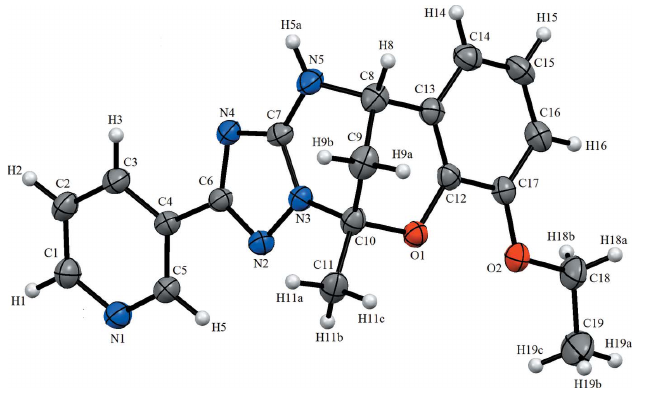
Figure 1 The molecular structure of the title compound, showing the atom labelling. Displacement ellipsoids are drawn at the 30% probability level.